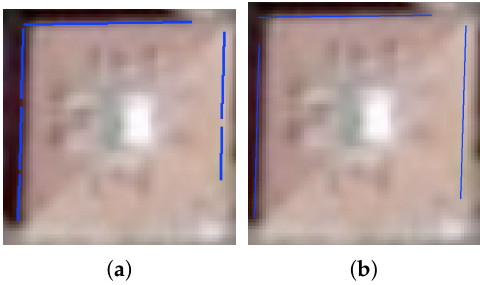
Figure 4. Figure 4a,b show the resultant output of the generated lines before and after the merging process,